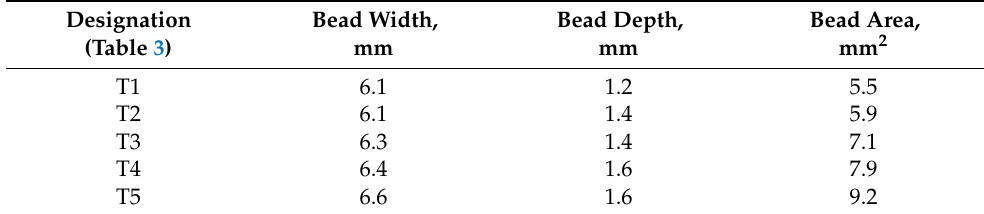
Figure 4. The macrostructure of laser alloyed surface layers (designation in accordance with Table 2). Table 4. Laser surface alloying process parameters.